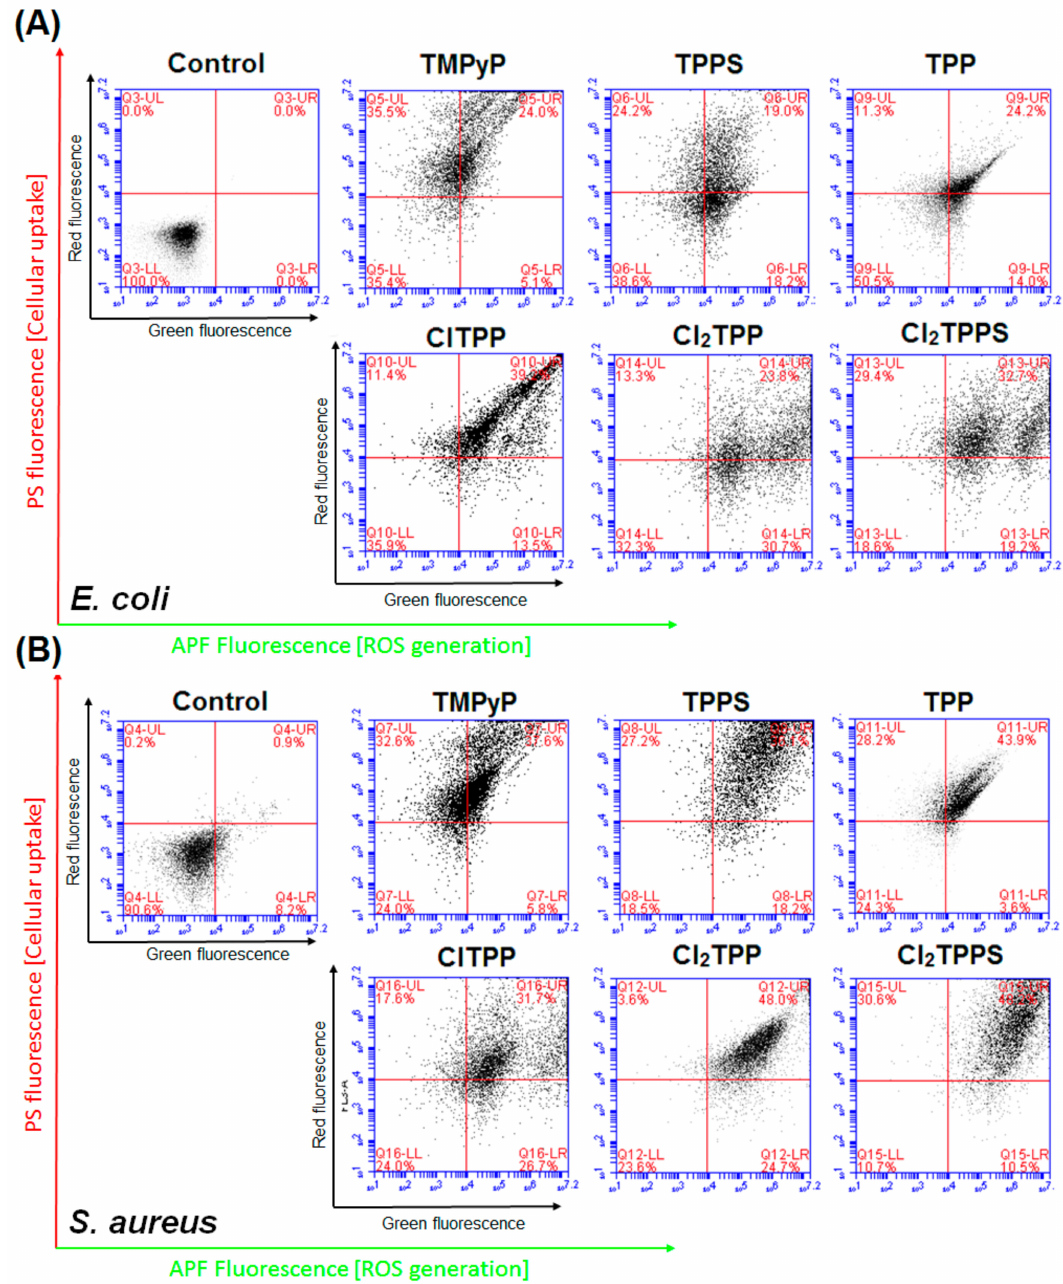
Figure 14. Flow cytometry analysis of reactive oxygen species (ROS) generation in vitro in ( A ) E. coli and ( B ) S. aureus . After incubation of bacteria with PS (2 h) and APF (2 h), the cells were irradiated with a sublethal light dose 10 J / cm 2 . The APF fluorescence signal monitored the level of ROS in the green channel, and the cellular uptake (red porphyrin fluorescence) was detected as an increased red fluorescence